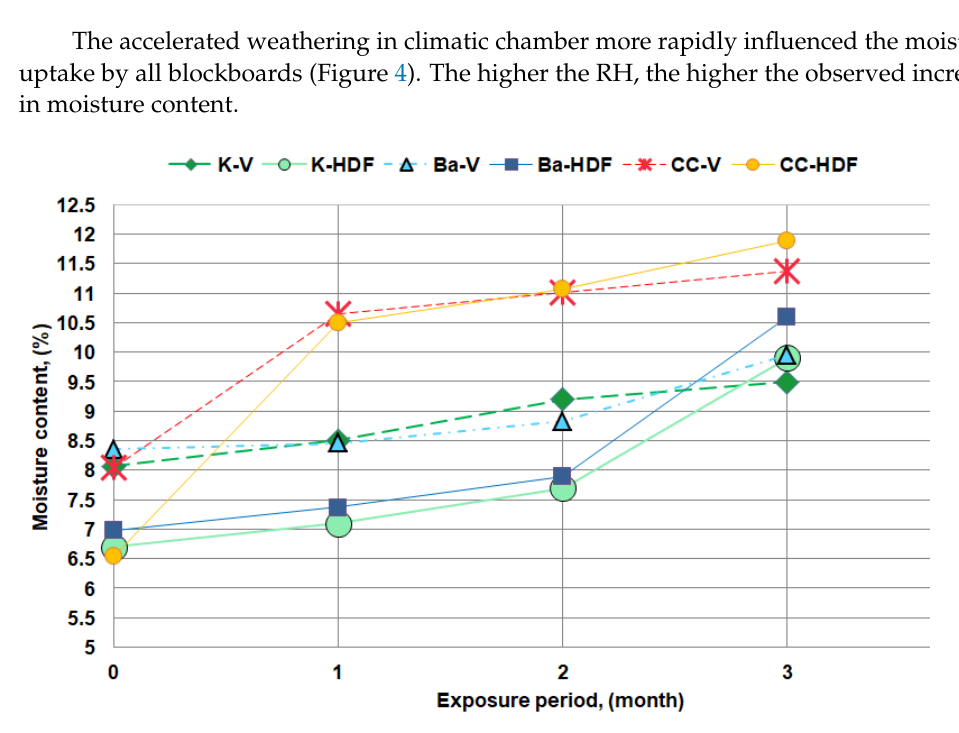
Values in the parenthesis are standard deviations.